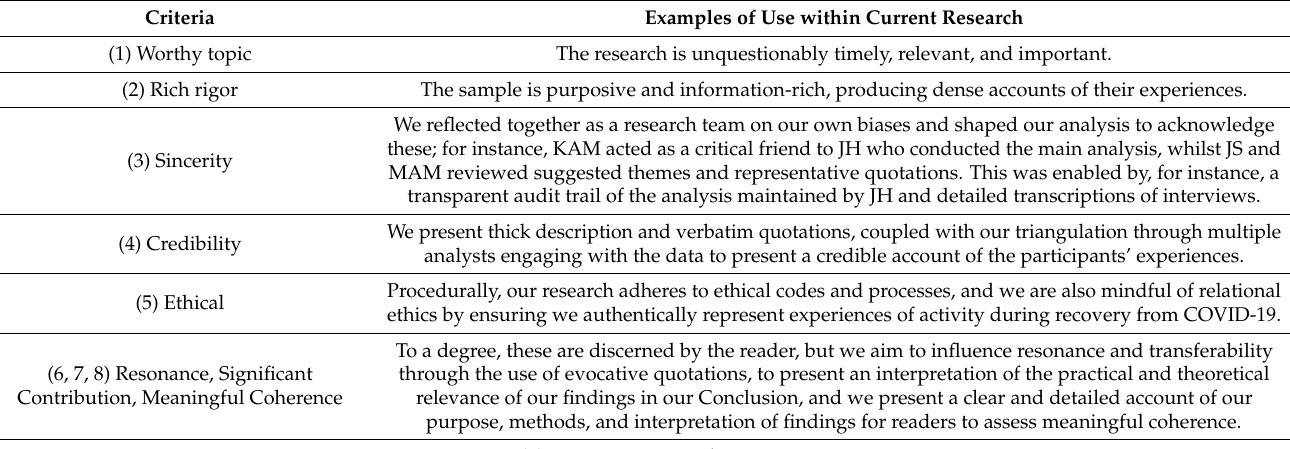
Table 1. Tracey’s “Big Tent”